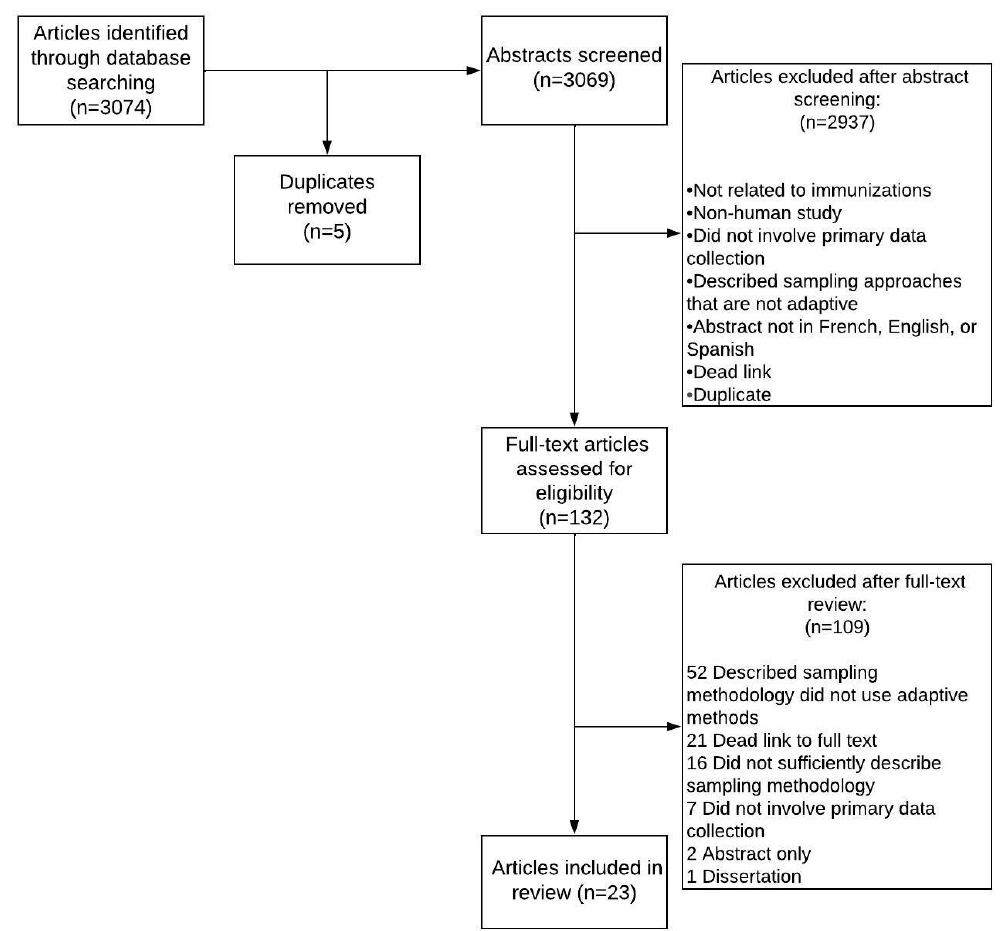
Figure 1. Flow diagram for study screening and selection.